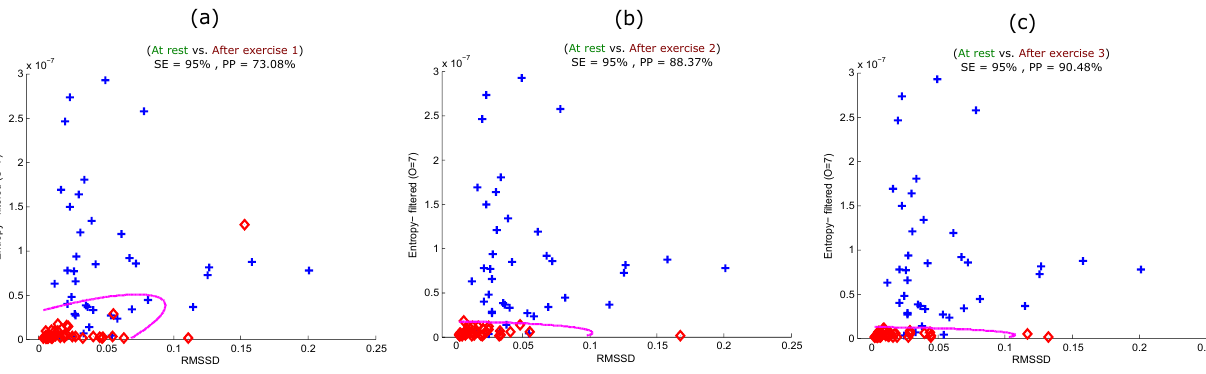
Figure 6. Quadratic classification of PPG signals measured before and after the simulated heat stress induction based on the optimal feature (entropy of the filtered PPG signal) and RMSSD. Here, RMSSD stands for the square root of the mean of the squares of the successive heartbeats intervals; SE stands for sensitivity; and PP stands for positive predictivity. ( a ) At rest vs. after exercise 1; ( b ) at rest vs. after exercise 2; ( c ) at rest vs. after exercise 3. The plus signs refer to subjects measured at rest, while the diamond signs refer to subjects measured after exercise (the simulated heat stress